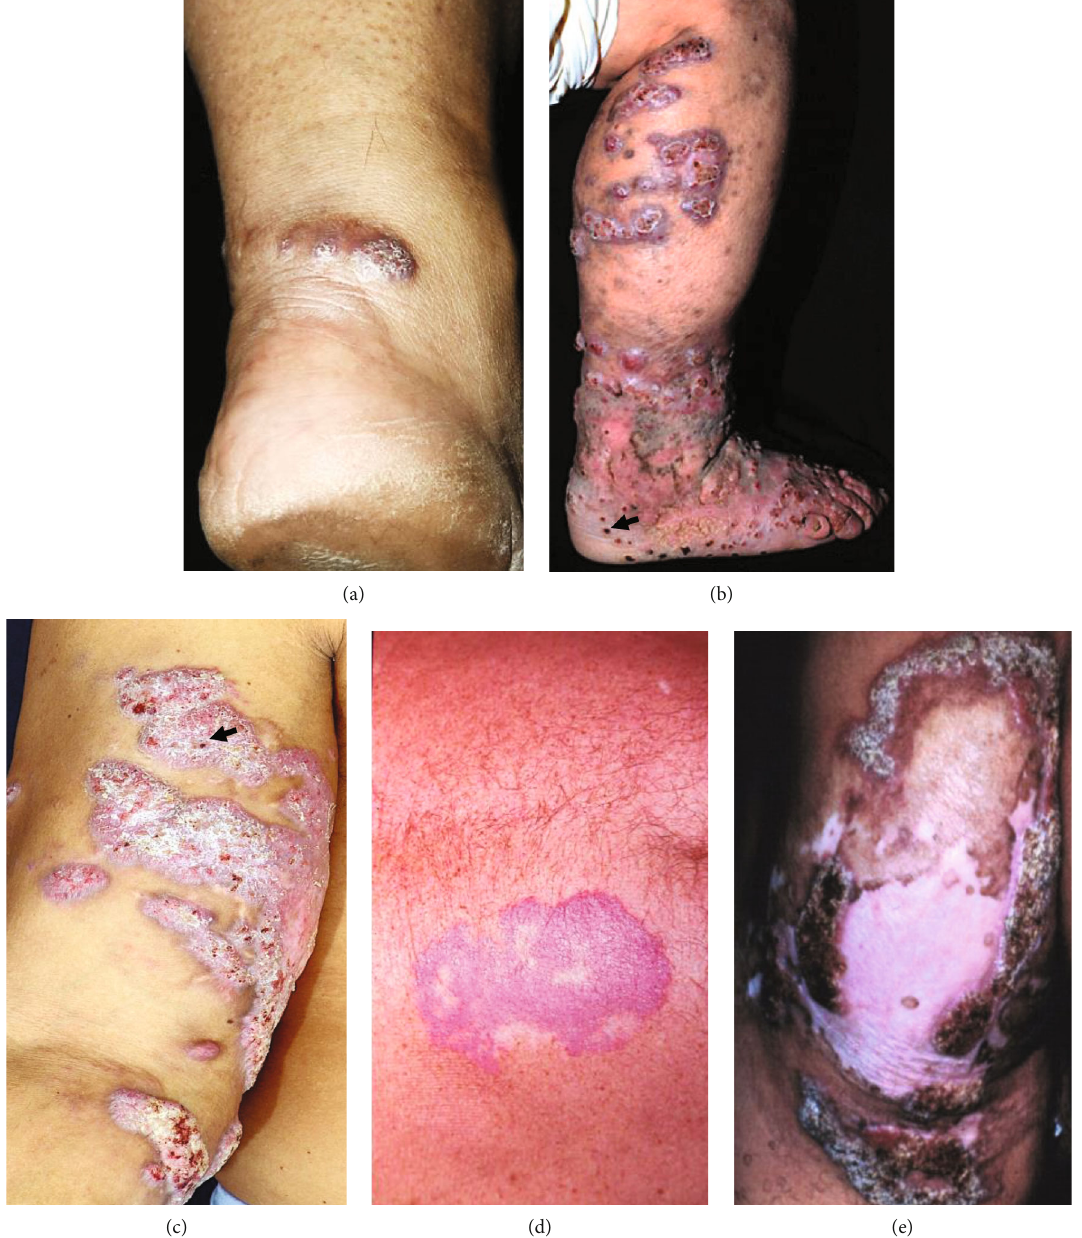
Figure 6: Five di ff erent clinical forms can be identi fi ed in patients with CBM, such as nodular (a), tumoral type (b), verrucous (c), plaque (d), and cicatricial (e) forms. The black arrow shows black dots in the